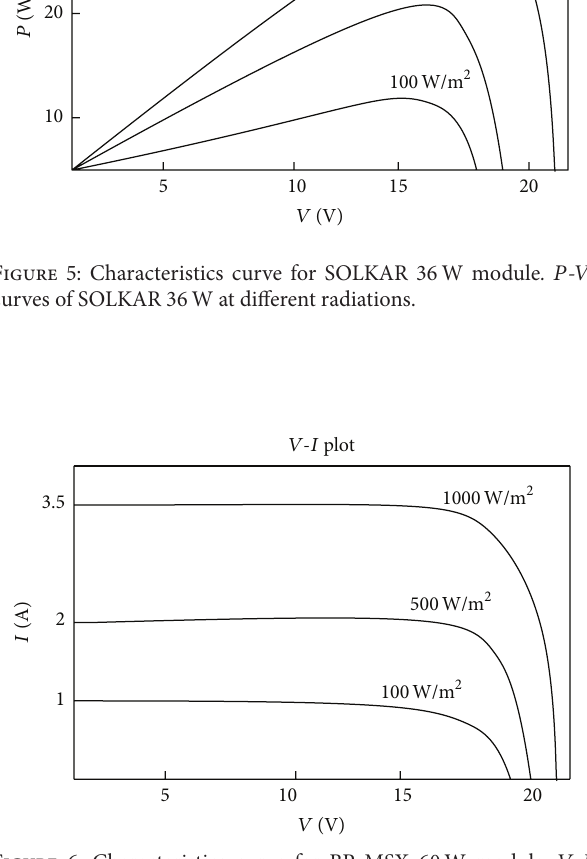
Figure 6: Characteristics curve for BP MSX 60W module . 𝑉 - 𝐼 curves of BP MSX 60W for different radiations.